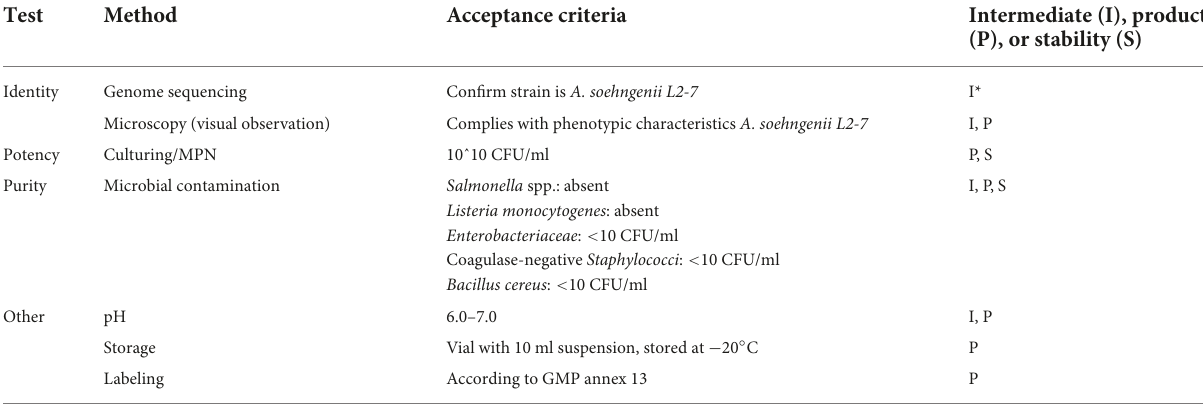
TABLE 1 Specifications for the Anaerobutyricum soehngenii intermediates and final